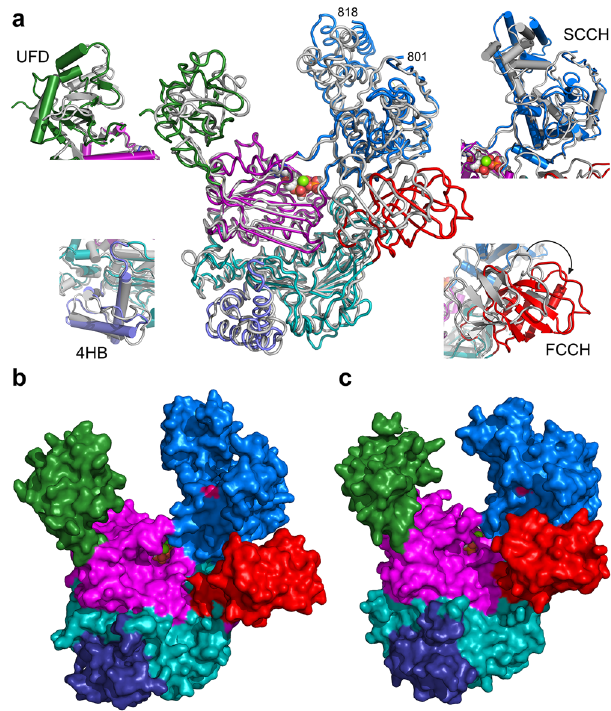
Fig. 3 | Comparison of the UBA6 and Uba1 structures. a Superimposition of the UBA6-ATPcomplexcolorcodedbydomainsasinFig.1withtheUba1-ATPcomplex in gray with both structures in loop representation. The Mg-ATP cofactorisshown in space fi lling representation. Differences in the 4HB, FCCH, SCCH and UFD are highlighted in ribbon diagrams utilizing the same color code. b Surface repre- sentation of the UBA6-ATP complex color coded by domains with the active site cysteine highlighted in pink. c Surface representation of the Uba1-ATP